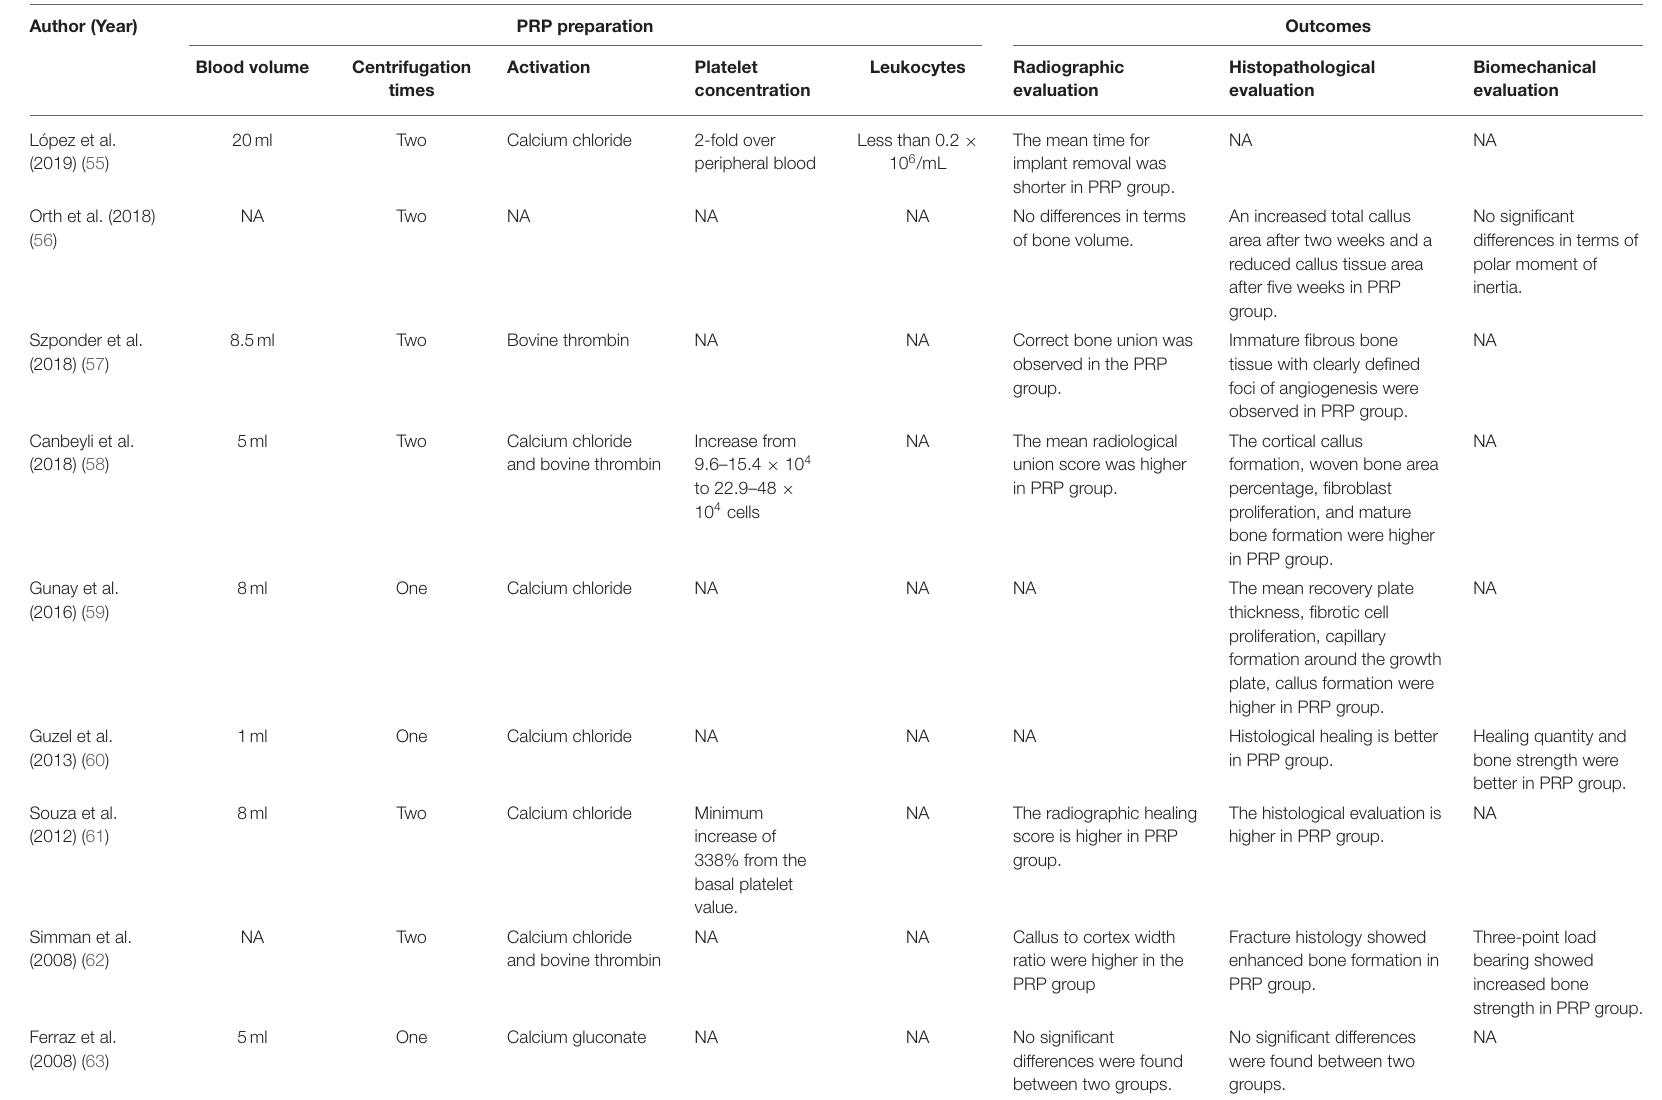
TABLE 3 | The PRP preparation and outcomes in animal